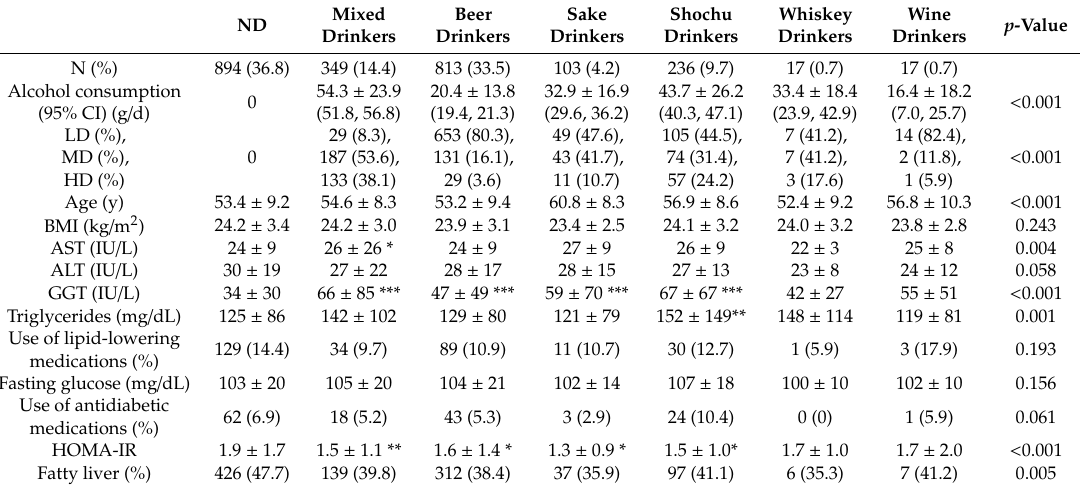
Table 4. Biological features of non-drinkers and various types of drinkers.